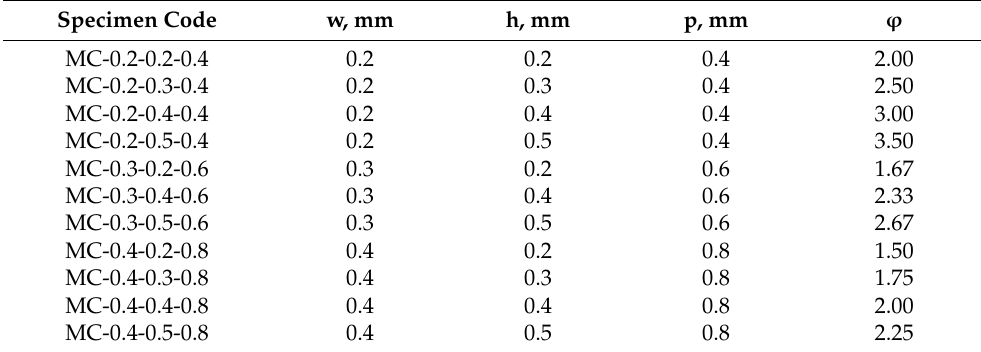
Figure 4. ( a ) View of the MC-0.2-0.5-0.4 surface and surface enlargement; ( b ) view of the plain, smooth specimen. Table 2. Surface codes and